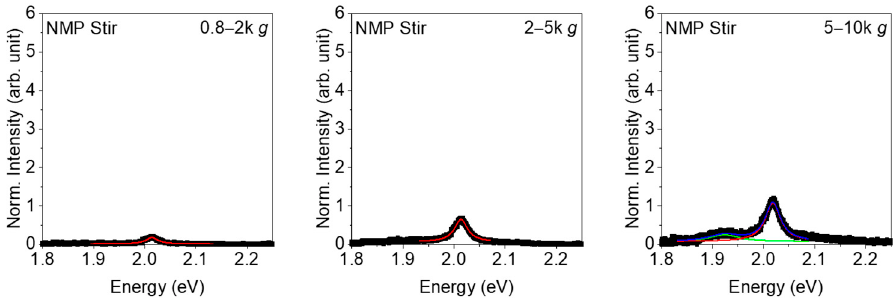
Figure A7. Photoluminescence spectra ( λ exc = 532 nm) the WS 2 nanosheet dispersions, exfoliated by tip sonication with a 30% amplitude. The bulk starting material was stirred in NMP prior to exfoliation. The PL was fitted by Lorentzians for quantitative analysis. Spectra of fractions which were collected during liquid cascade centrifugation but did not show any PL are excluded.